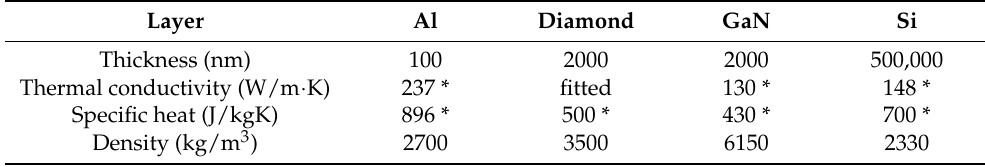
Table 2. Fixed parameters for different materials in the sample.